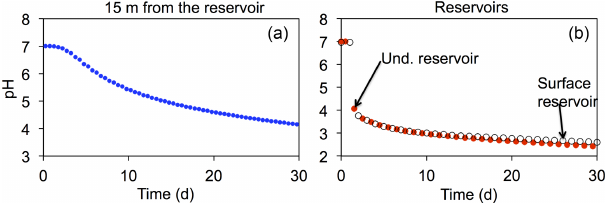
Figure 3. pH differences in the surface (a) and underground reser- voirs (b)